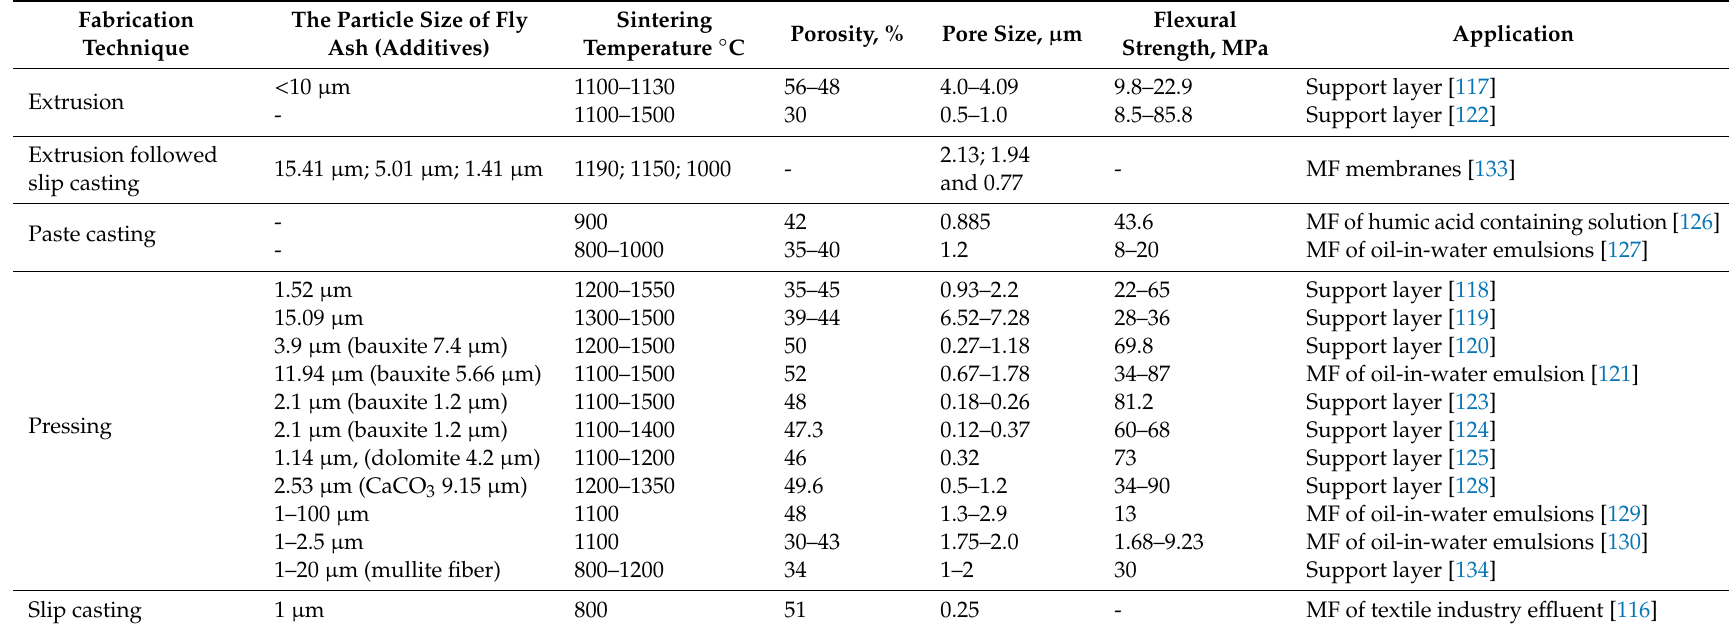
Table 3. Membranes fabricated using fly ash as a main raw